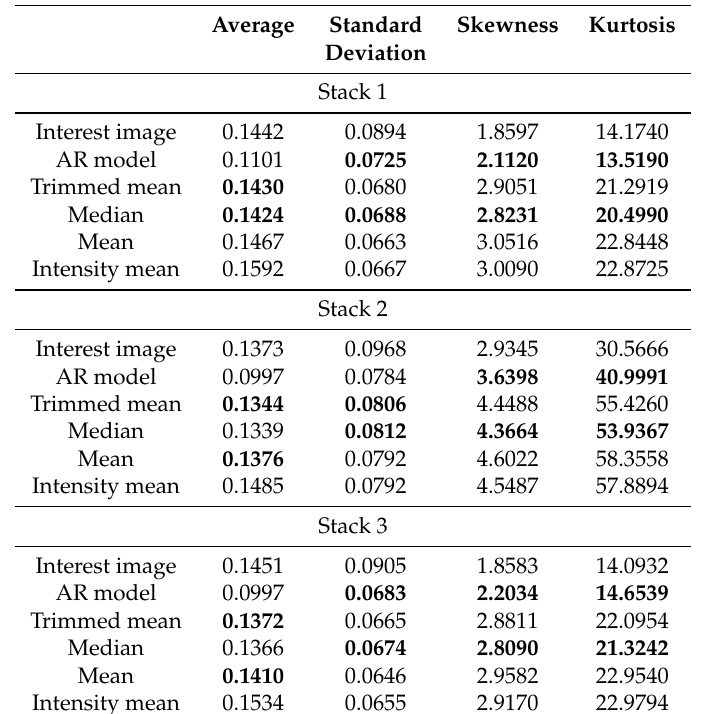
Table 1. Average, standard deviation, skewness, and kurtosis of one interest image and the ground scene prediction. The interest image in Stacks 1, 2 and 3, is the image of mission 1 and passes 1, 2 and 5, respectively. The two values of each measure that yielded the closest values with the interest image are highlighted